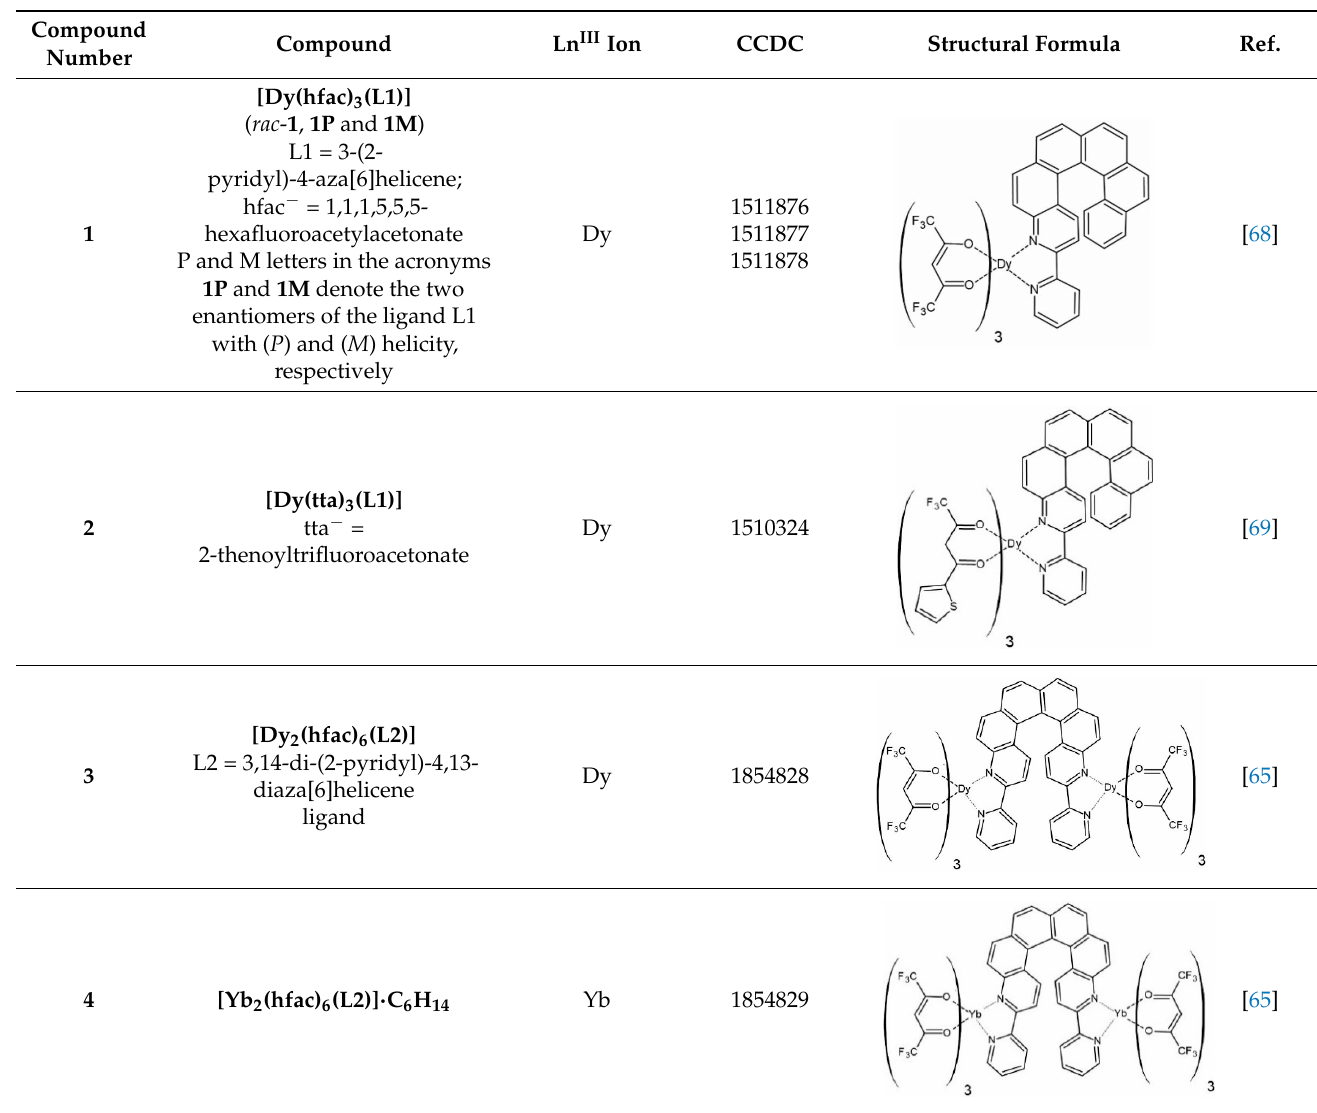
Table 1. A chronological summary of all published lanthanide-helicene complexes characterized structurally, with the CCDC numbers referring to their crystal structures deposited with the Cambridge Structural Database (CSD). The CSD database was searched using the WebCSD tool on 7 July 2021.